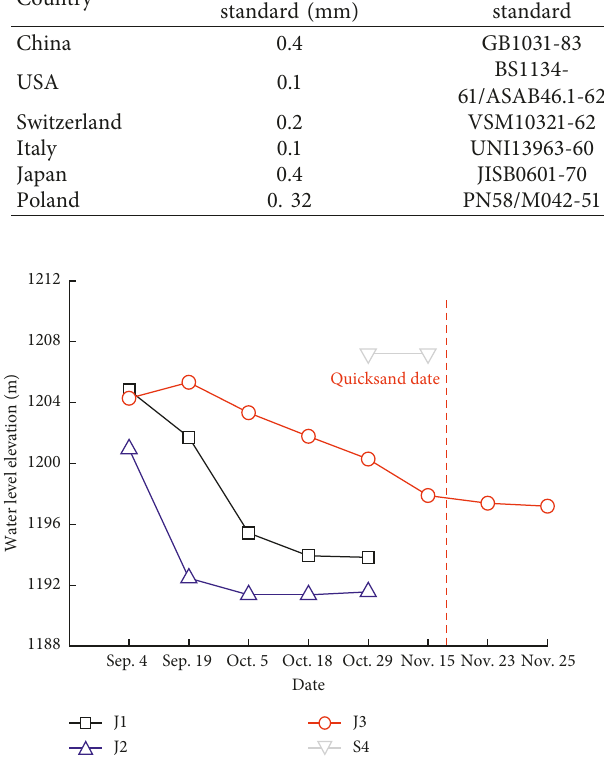
Figure 11: Water level elevation of Sarah Wusu group aquifer in hydrological